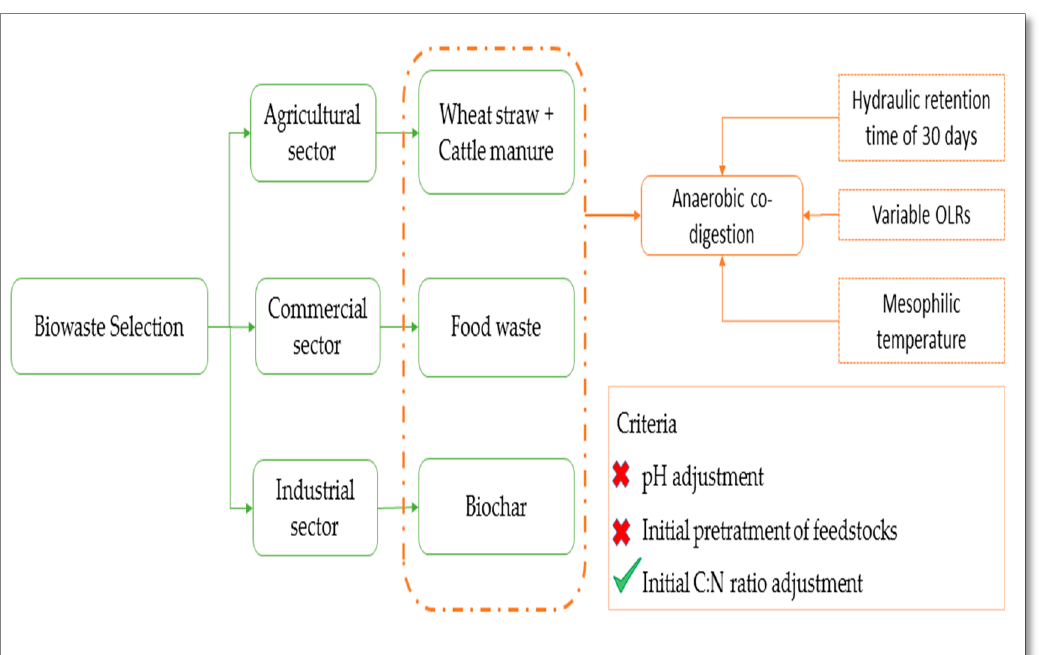
Figure 2. Project requirements and approach.